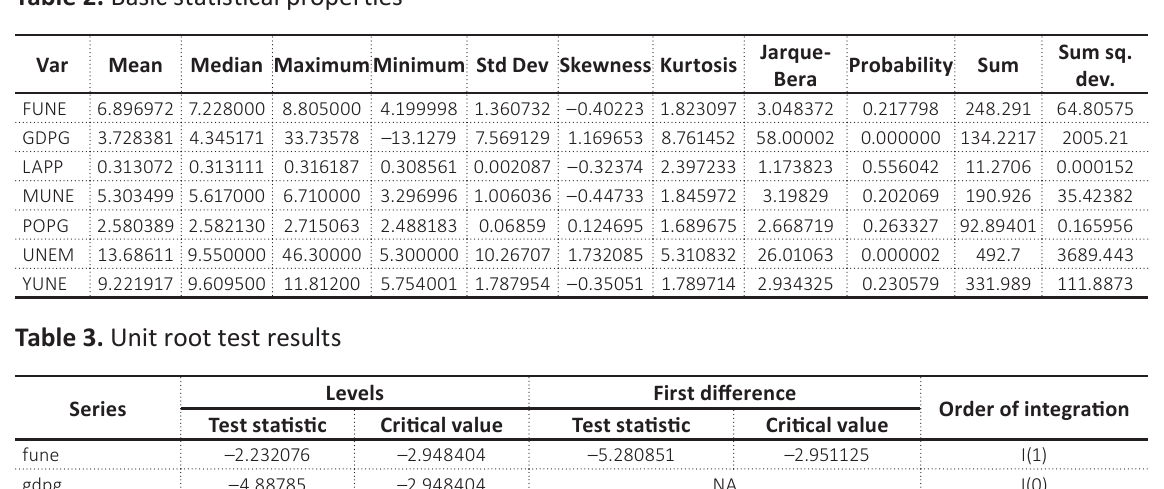
Table 2. Basic statistical properties